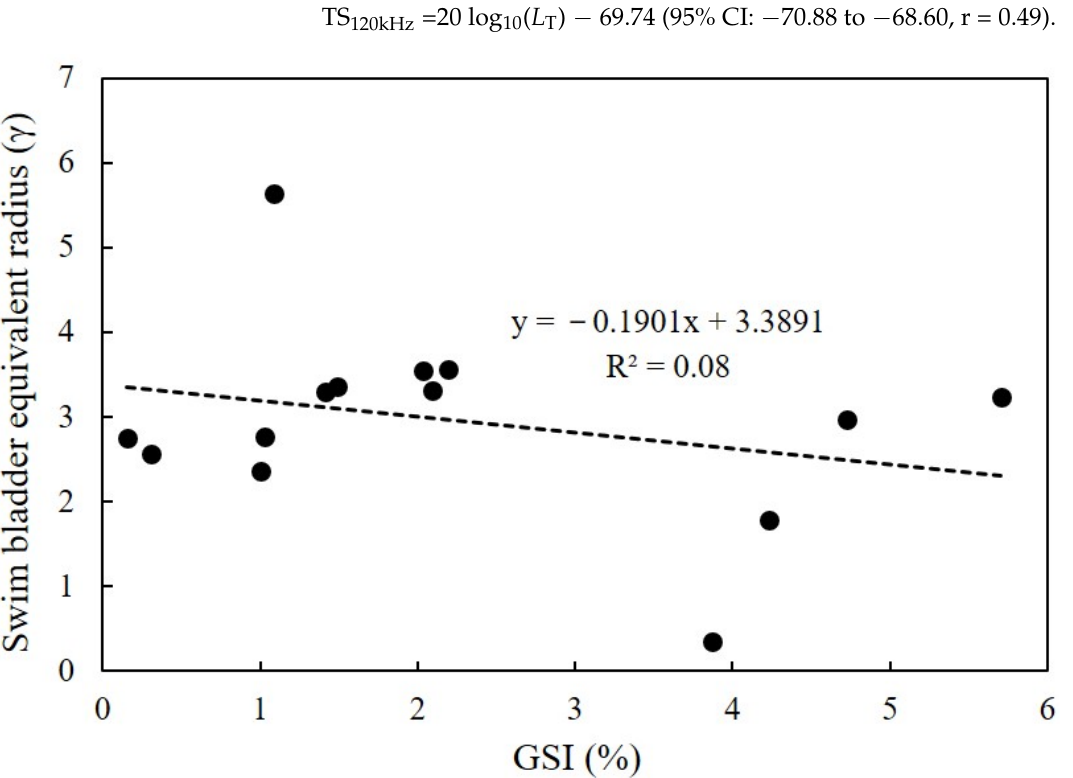
Figure 4. The relationship between Pacific herring L T and the swim bladder equivalent radius (r).